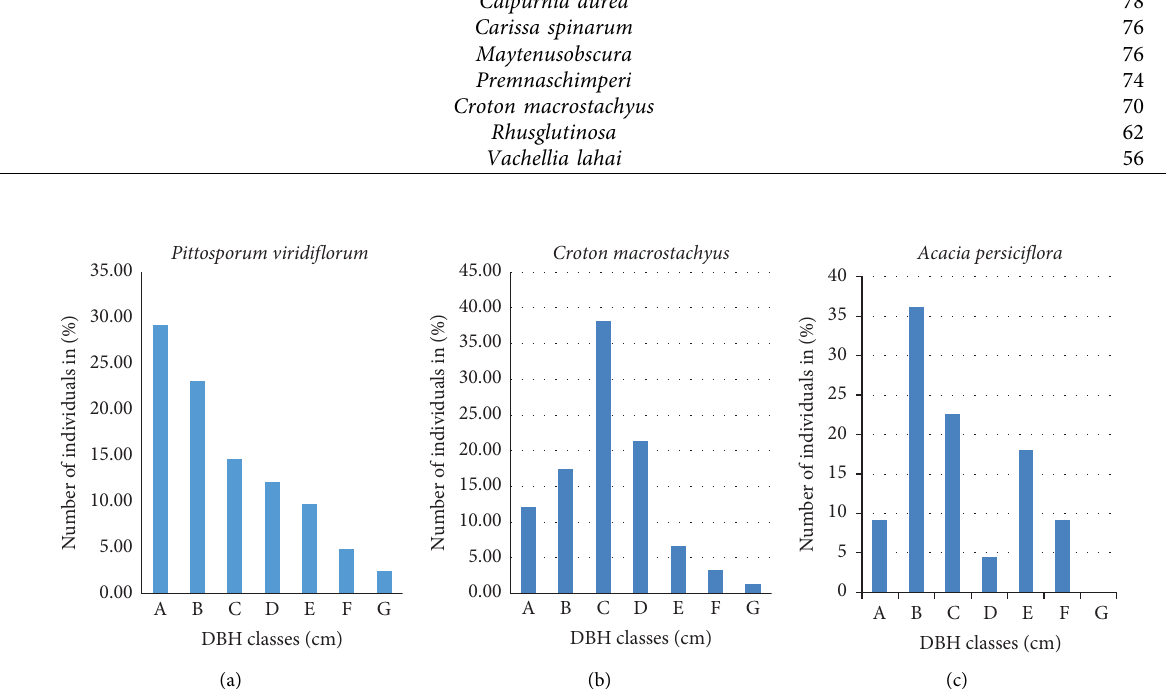
Figure 5: DBH distribution patterns of some group of woody species; Pittosporumviridiforum (a), Croton macrostachyus (b), and Senegalia persicifora (c) of representative woody species. DBH classes: A � 2.5–5cm, B � 5.1–10cm, C � 10.1–15cm, D � 15.1–20cm, E � 20.1–30cm, F � 30.1–40cm, and G � > 40cm. Table 4: Basal area (BA) comparison of St Michael Church Forest with other fve afromontane forests (m 2 ha − 1 ).